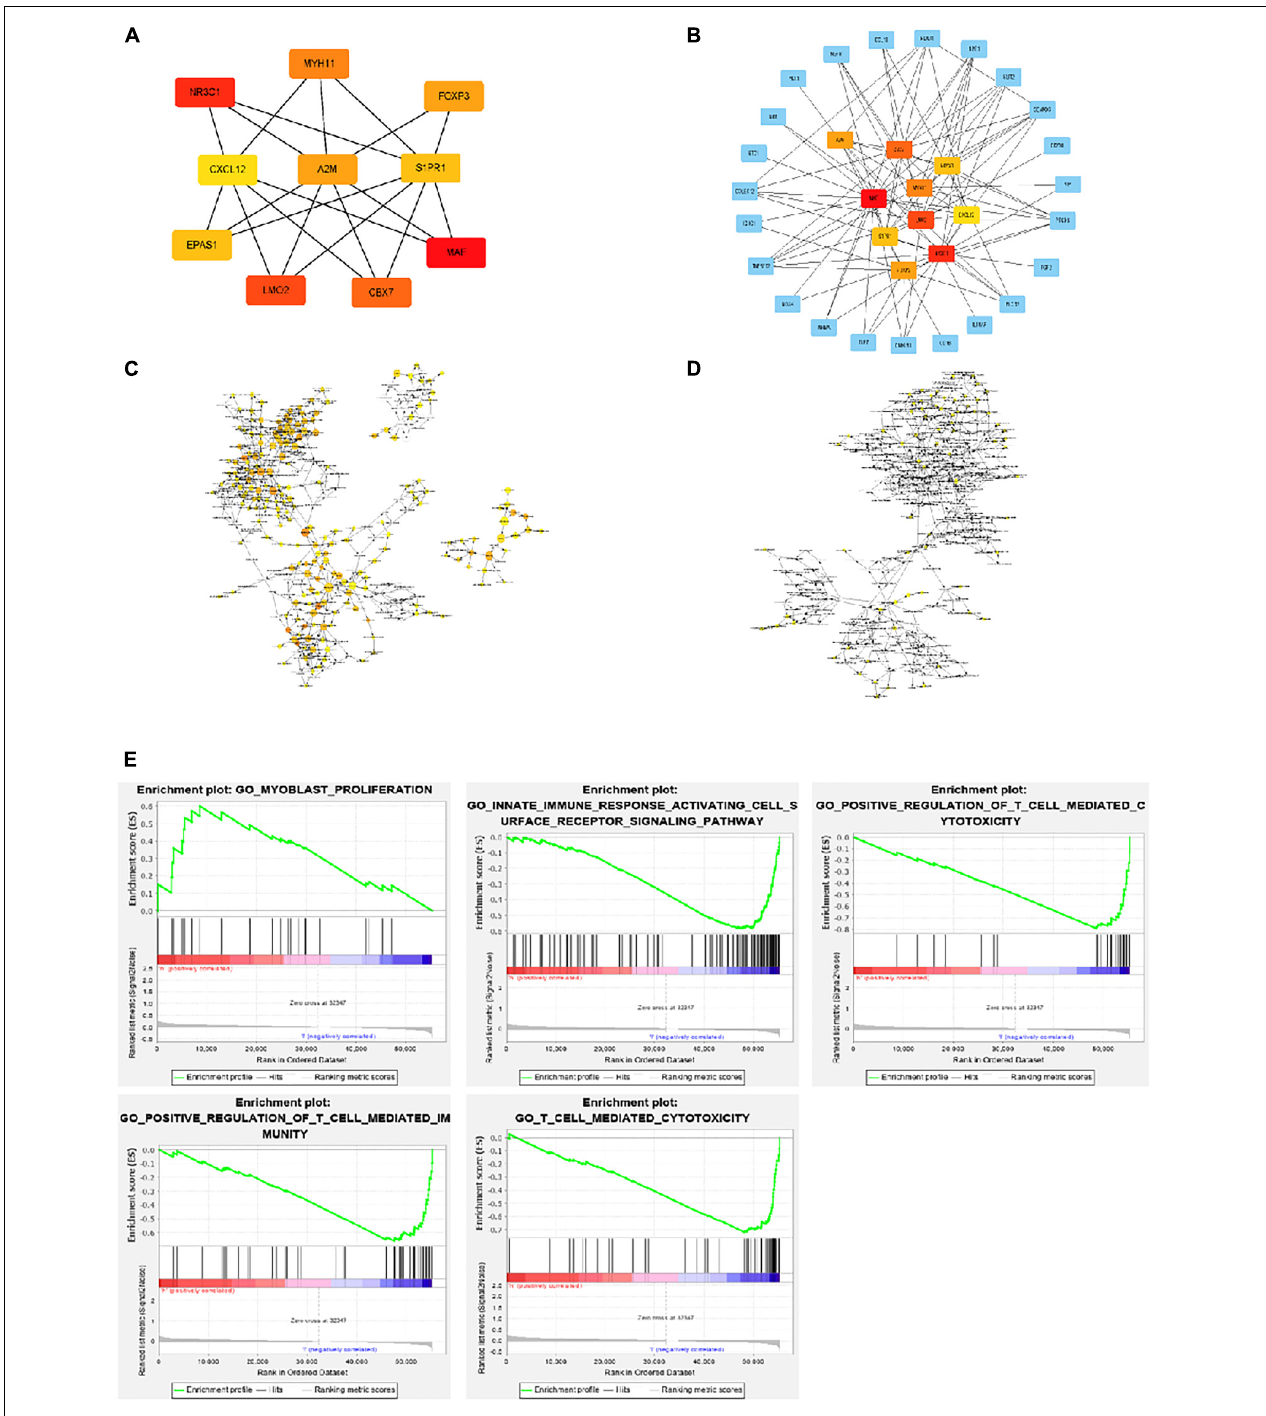
FIGURE 4 | Interaction network and biological process analysis of the hub genes. (A) Top 10 hub genes screened from the regulatory network. (B) Top 10 hub genes and their first neighbors that are screened from the regulatory network. Hub gene is shown in red to orange on the left. The first neighboring node is shown in blue. The right picture shows the characteristics of the genes in the left picture. The green ones are low-risk genes. The red ones are high-risk genes. The triangles are transcription factors. (C) The biological process analysis of genes in the network was constructed using BiNGO. The color depth of nodes refers to the corrected P value of ontologies. The size of nodes refers to the number of genes that are involved in the ontologies. P < 0.01 was considered statistically significant. (D) The biological process analysis of hub genes was constructed using BiNGO. P < 0.05 was considered statistically significant. (E) Ten-hub-gene enrichment plots from Gene Set Enrichment Analysis